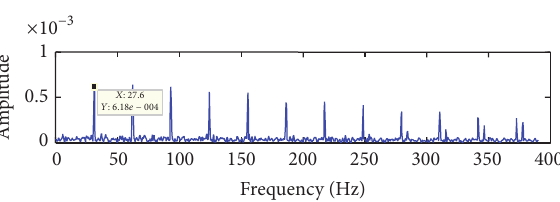
Figure 6: Time-frequency envelope.